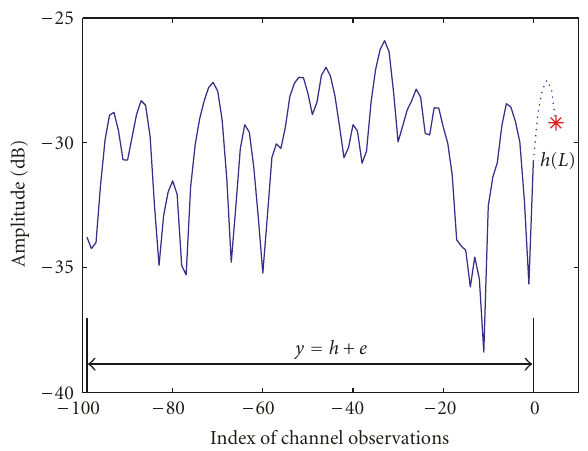
Figure 1: Prediction of Rayleigh fading